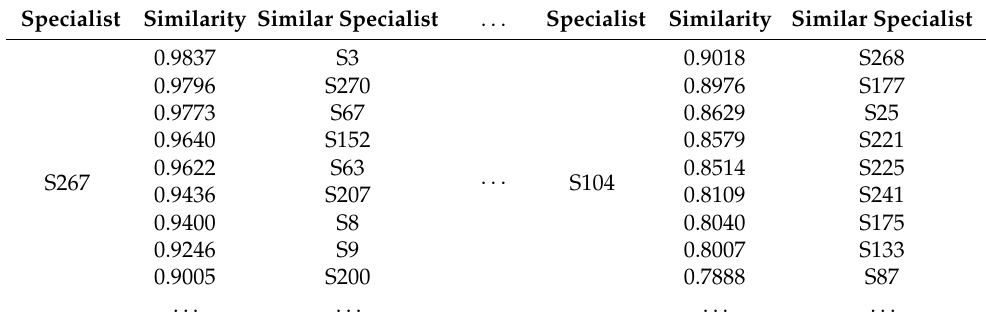
Table 5. Similarity of topic